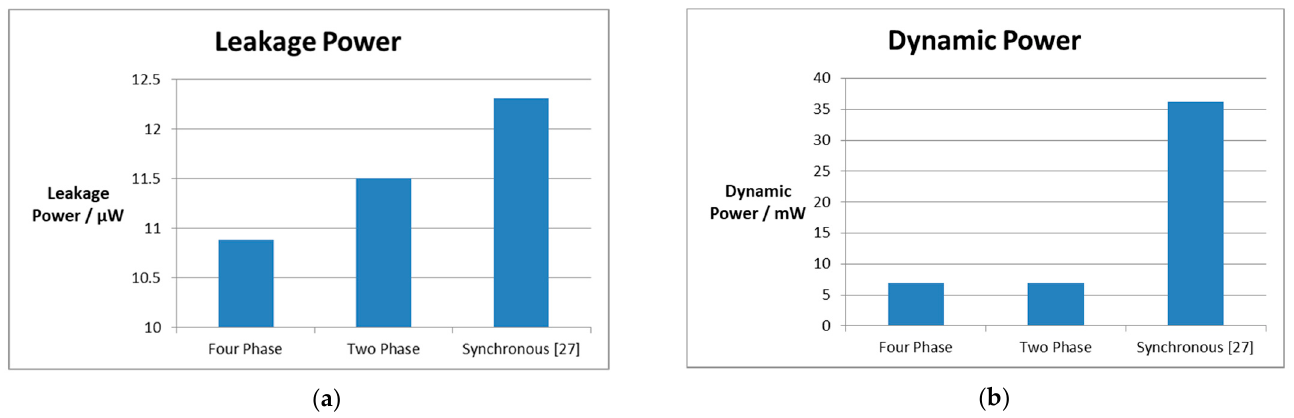
Figure 10. Power comparisons among the three protocols under uniform random traffic for a circuit-switched NoC for the ( a ) leakage power and ( b ) dynamic power.